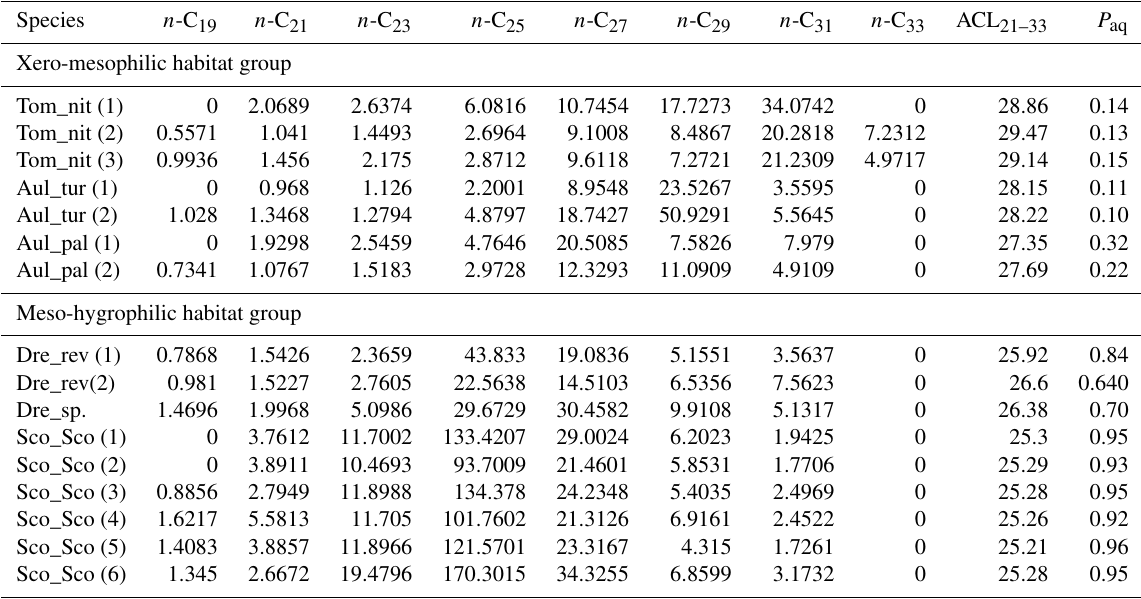
Table 2. The concentration (µgg − 1 , dry weight), ACL 21–33 and P aq (after Ficken et al., 2000) of n -alkanes in brown-moss samples. (Num- bers in brackets relate to the sample